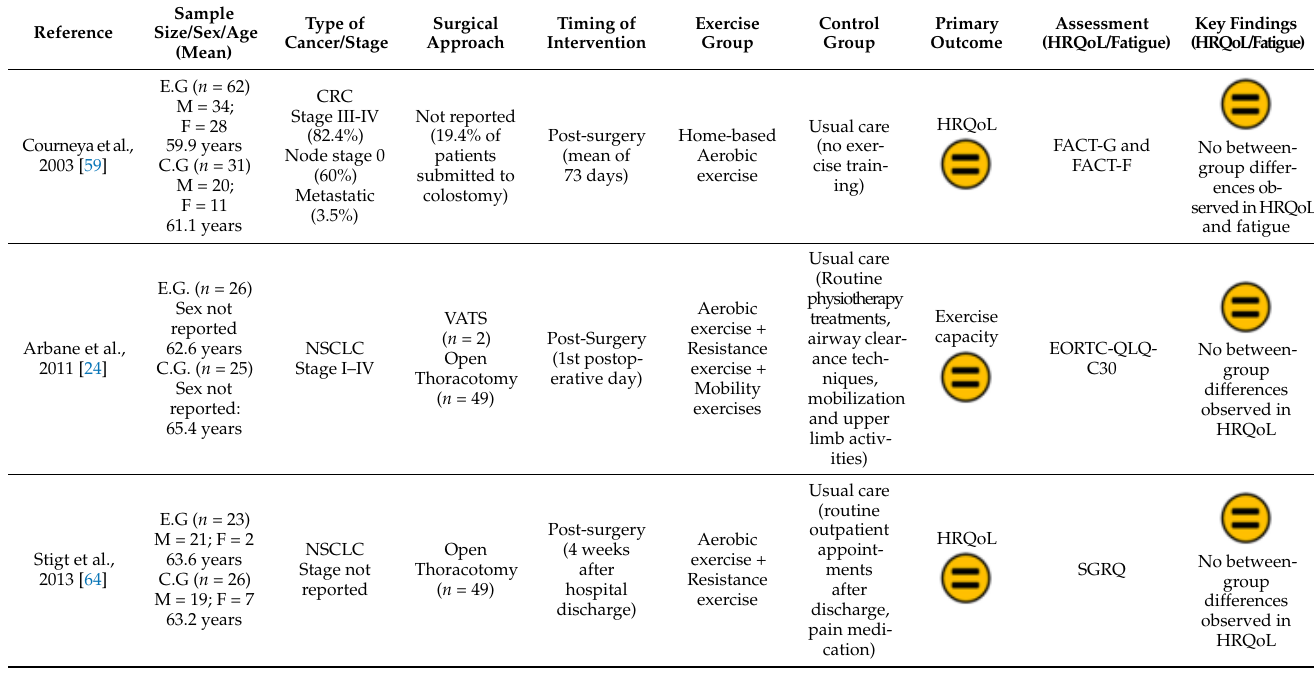
Table 1. Characteristics of included studies/participants and key